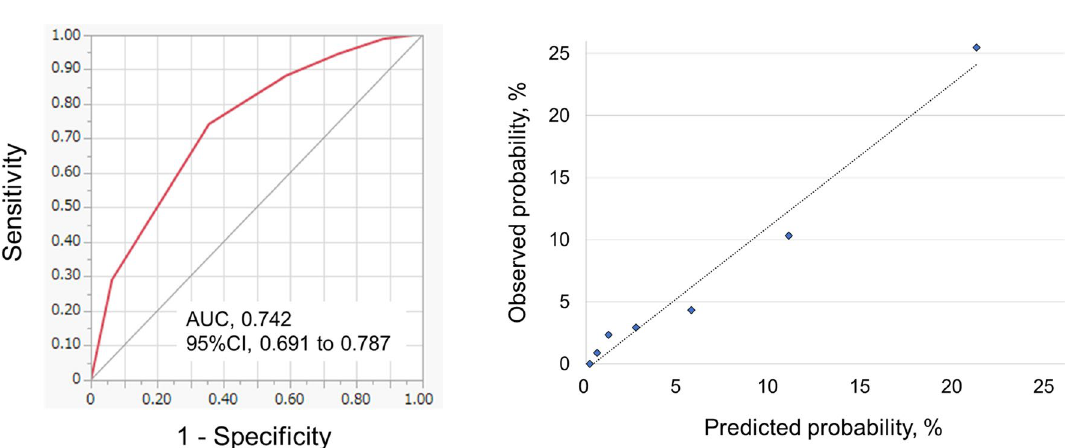
Table 4. Association of presence of DIC on day 1 with the J-ERATO score among all study subjects. Logistic regression models were used with adjustment for J-ERATO score, event location, circumstances of the occurrence, medical history of psychiatric disorder, and age.DIC, disseminated intravascular coagulation; OR, odds ratio; CI, confidence interval.